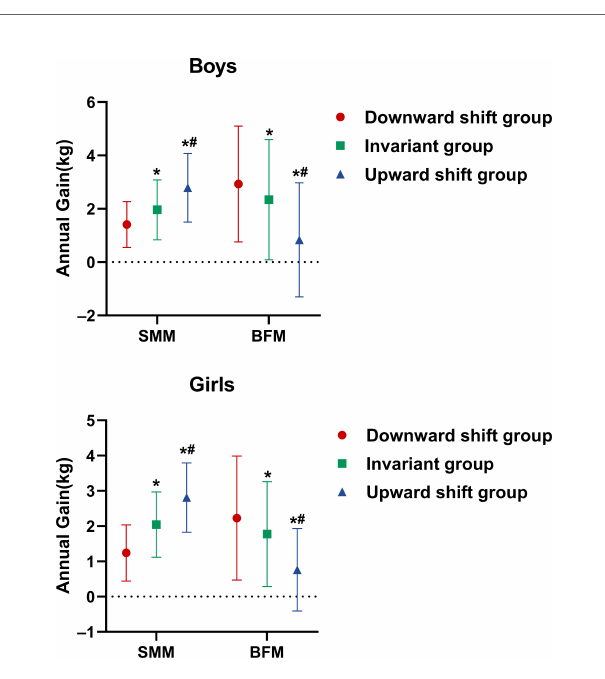
FIGURE 6 | Correlation of annual SMM and BFM gains with growth curve ’ s shifting mode in the 2-year follow-up. *Signi fi cant difference to the downward shift group ( p < 0.05). # Signi fi cant difference to the invariant group ( p <